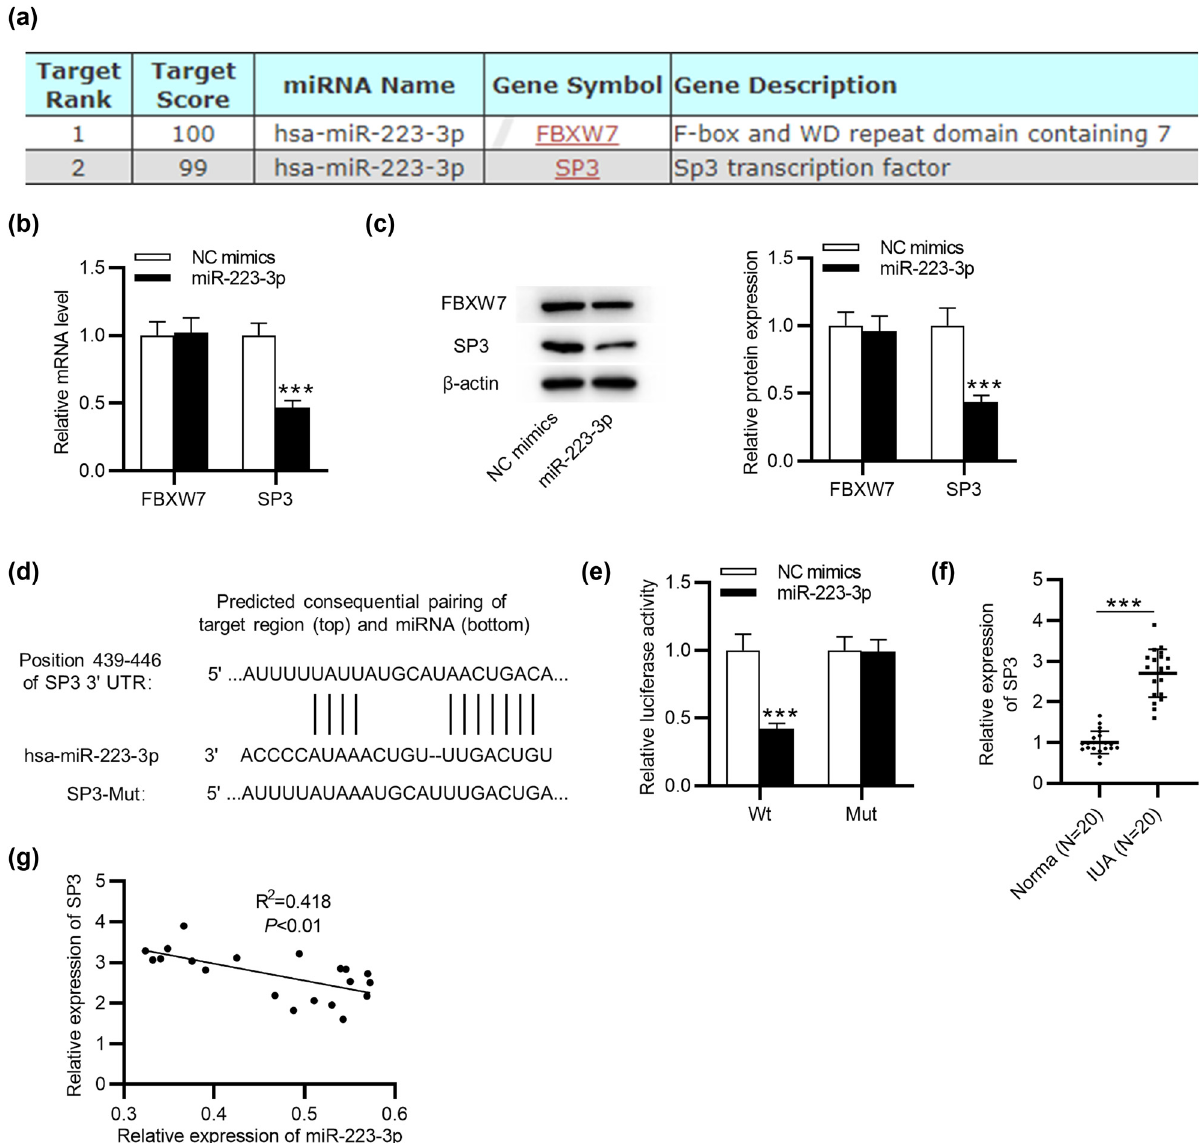
Figure 3: MiR - 223 - 3p targets SP3. ( a ) MiRDB was used for predicting downstream targets of miR - 223 - 3p. ( b ) The mRNA levels of FBXW7 and SP3 in transfected - EECs analyzed by RT - qPCR. ( c ) Protein levels of FBXW7 and SP3 in EECs after overexpressing miR - 223 - 3p detected by western blotting. ( d ) TargetScan was used for predicting the complementary site of miR - 223 - 3p on SP3 3 ′ UTR. ( e ) A luciferase reporter assay for detecting the association between SP3 3 ′ UTR and miR - 223 - 3p in EECs. ( f ) RT - qPCR analysis of SP3 level in IUA and normal tissues ( N = 20 pairs ) . ( g ) Pearson analysis for analyzing the correlation between miR - 223 - 3p and SP3 expression in IUA tissues ( N = 20 ) . All experiments were performed in triplicate and data are presented as the mean value ± SD. Student ’ s t - tests were performed for statistical analysis. *** p < 0.001, miR - 223 - 3p vs NC mimics group or IUA vs normal